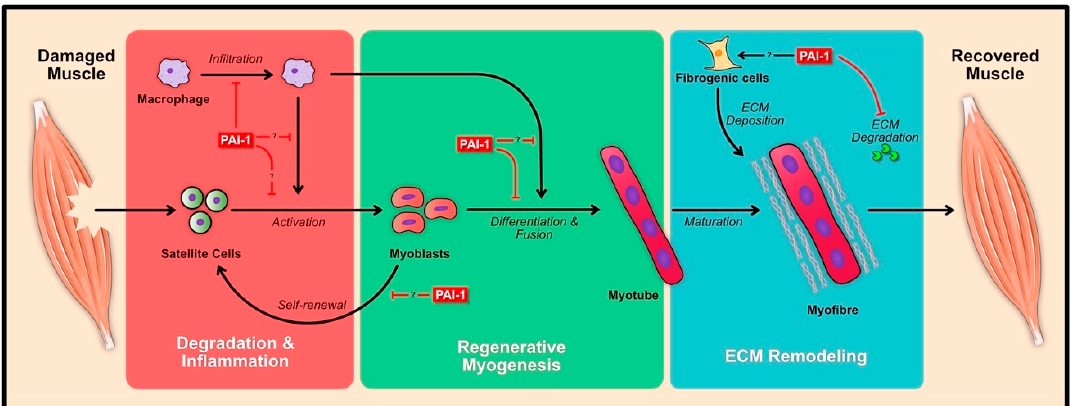
Figure 3. Effects of PAI-1 during skeletal muscle regeneration. Induction of muscle damage results in the swift infiltration of immune cells (macrophages shown), resulting in the degradation of cellular debris and activation of satellite cells to form myoblasts. The activated myoblasts differentiate and fuse to form myotubes, which then mature within their niche to form complete myofibres. PAI-1 has been shown to inhibit the regeneration process at various levels (red bar lines), however the role of PAI-1 relating to satellite cell, myoblast and other cells (immune and fibrogenic cells) during regeneration has yet to be explored. Solid black arrows indicate activation. Red bars indicate inhibition or blockage.